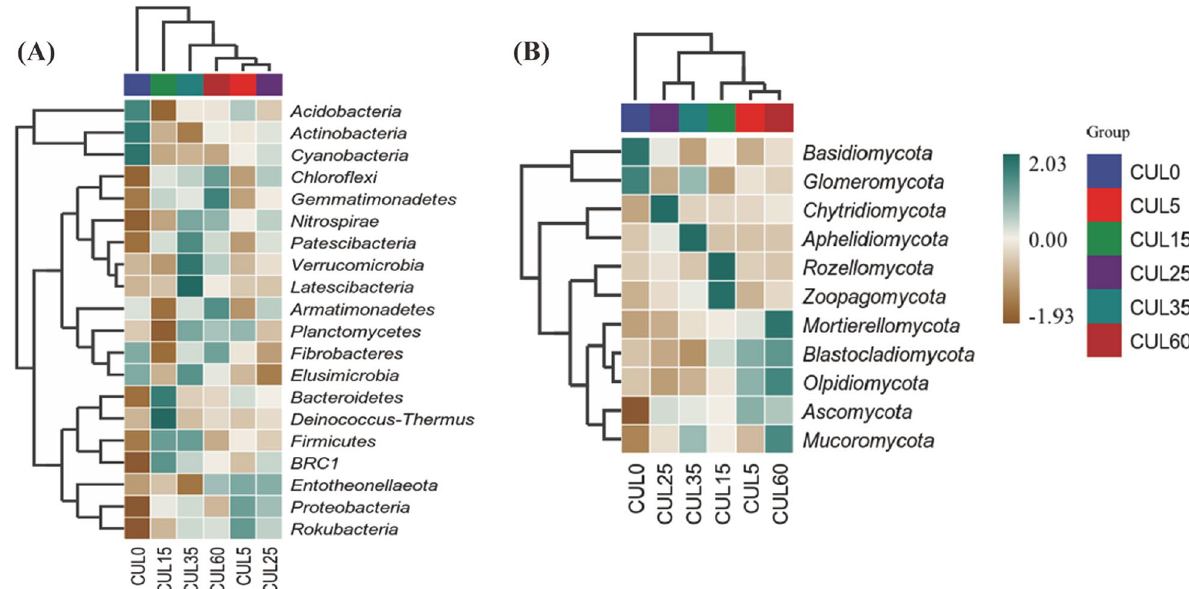
Fig. 4 Cluster heatmaps of bacterial and fungal communities at phylum level: A bacteria; B fungi. Only the 20 phyla with highest average abundance in any soil sample are shown